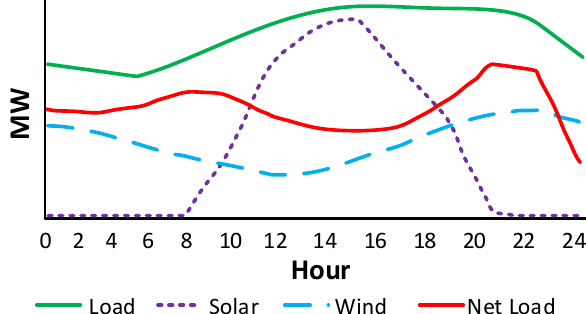
Figure 2. Illustrative example of net load profile with solar and wind